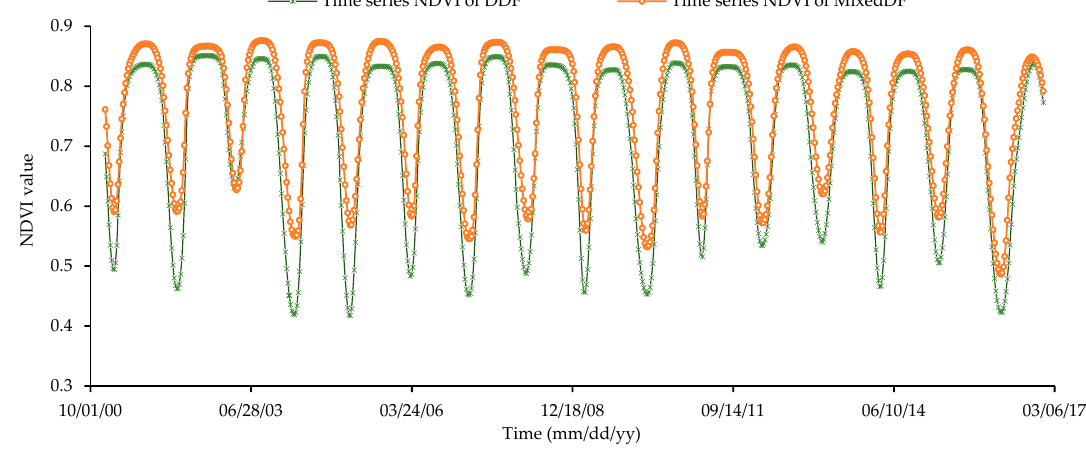
Figure 9. Example of seasonal different in NDVI timing values of DDF ( green ) and MDF (red) period 2001–2016.